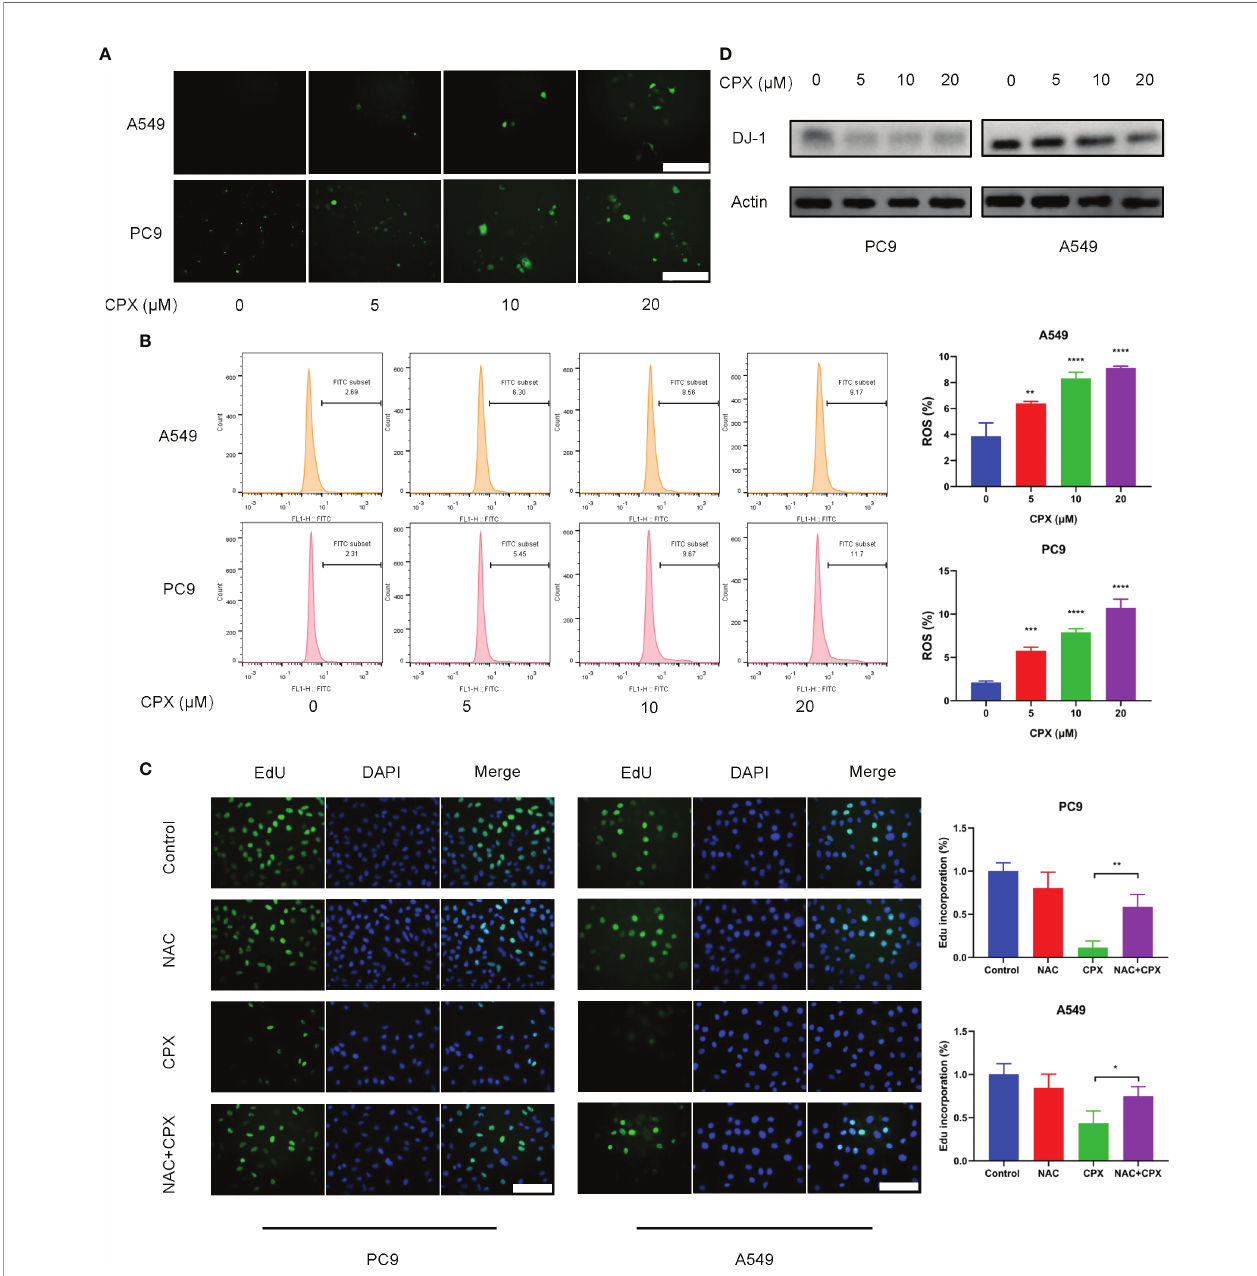
FIGURE 3 | CPX increases intracellular ROS levels. (A) Cells treated with indicated CPX concentrations were stained with DCFH-DA and photographed under fl uorescence microscopy to evaluate ROS levels. Scale bar = 100 m m. (B) Flow cytometry was used to analyze ROS levels in cells treated with indicated CPX concentrations by DCFH-DA staining. (C) EdU assay showing LUAD cells treated with or without 2 mM NAC in the presence or absence of 20 m M CPX for 24 hours. Scale bar = 100 m m. (D) Western blot showing DJ-1 levels in LUAD cells pretreated with indicated CPX concentrations for 24 hours. *P < 0.05; **P < 0.01; ***P < 0.001; ****P < 0.0001. Statistical signi fi cance compared with respective control